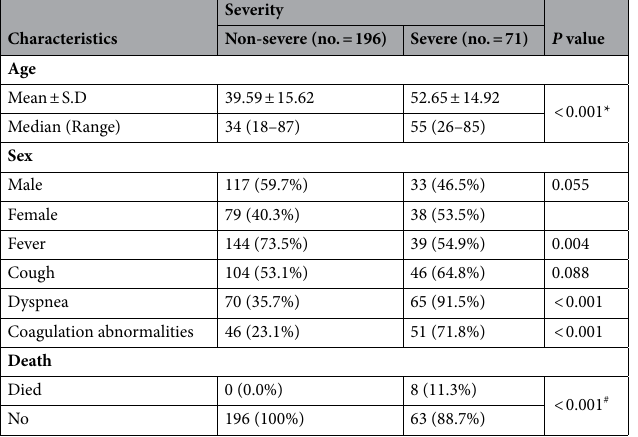
Table 1. Demographic, clinical data and outcome among severe and non-severe patients (no. = 267). P-value was calculated by Chi-Square Test. *P-value was calculated by Mann Whitney test. # P-value was calculated by Fisher’s Exact Test. P-value < 0.05 is statistically